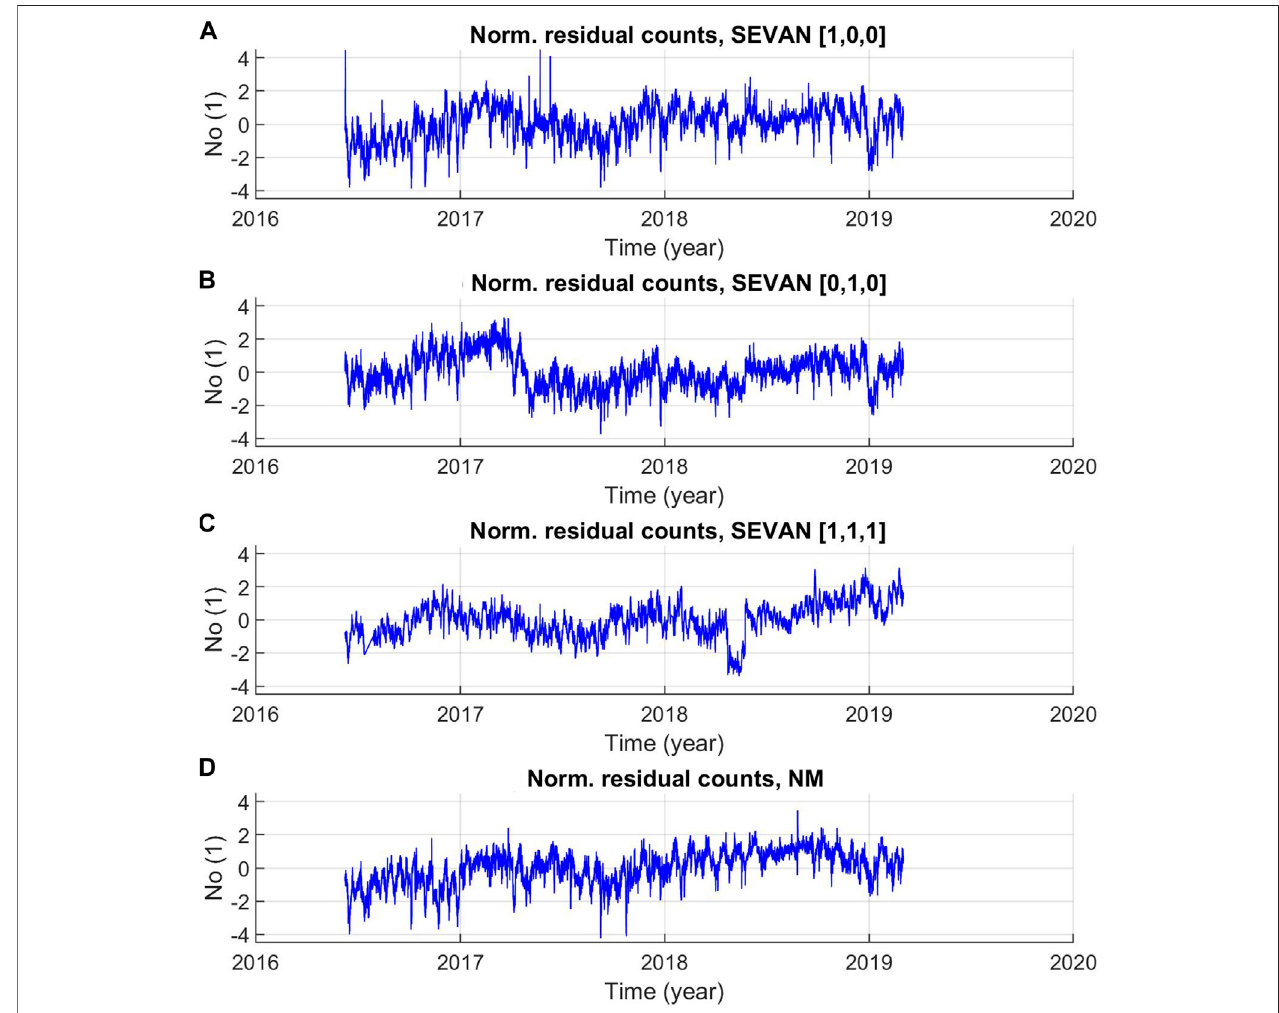
FIGURE 4 | Normalized pressure-corrected counts observed using the SEVAN (A, B, C) and an NM (D) on LS.